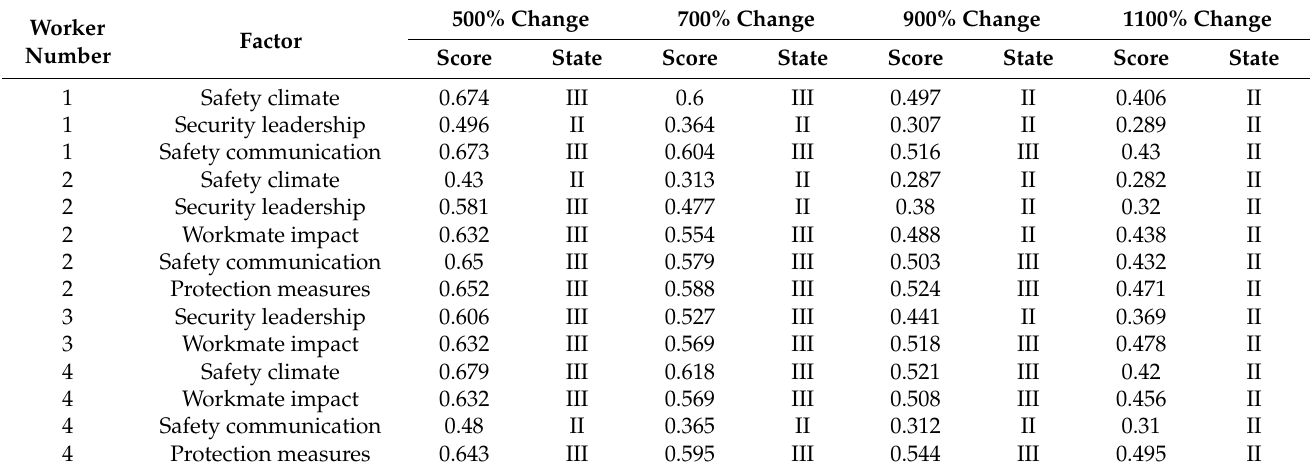
Table 16. Sensitivity analysis results.